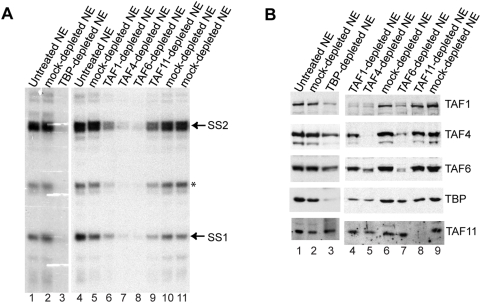
TFIID present in nuclear extracts contributes in X mRNA transcription, but TAF11 is dispensable.(A) In vitro transcription assays of immmunodepleted nuclear extracts (NEs). To examine importance of TFIID for X gene transcription, TFIID was depleted from NEs using antibodies raised against different TFIID subunits and the depleted NEs were tested for X gene transcription activity using the HBV enhancer-X promoter construct. SS1 and SS2: primer extension products showing transcription from Start site 1 and Start site 2, respectively. The asterisk shows a primer extension product that was not consistently observed. (B) Western blot analyses of the immunodepleted NEs. Depleted NEs were examined for the levels of TAF1, TAF4, TAF6, TAF11, and TBP.